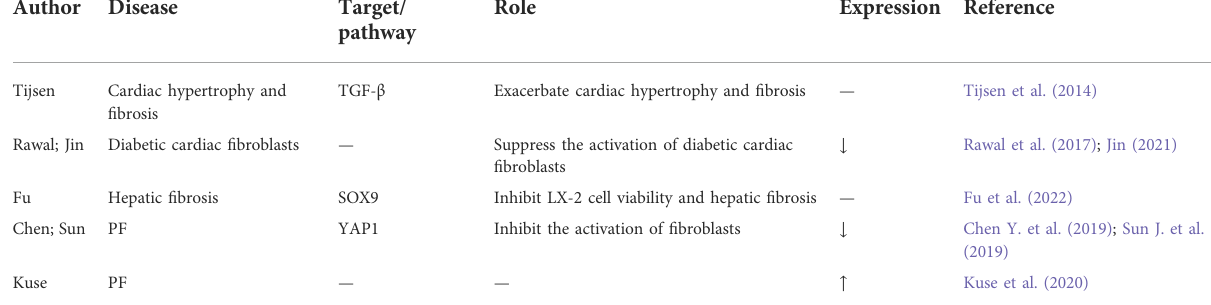
TABLE 9 The roles of miR-15a in lung